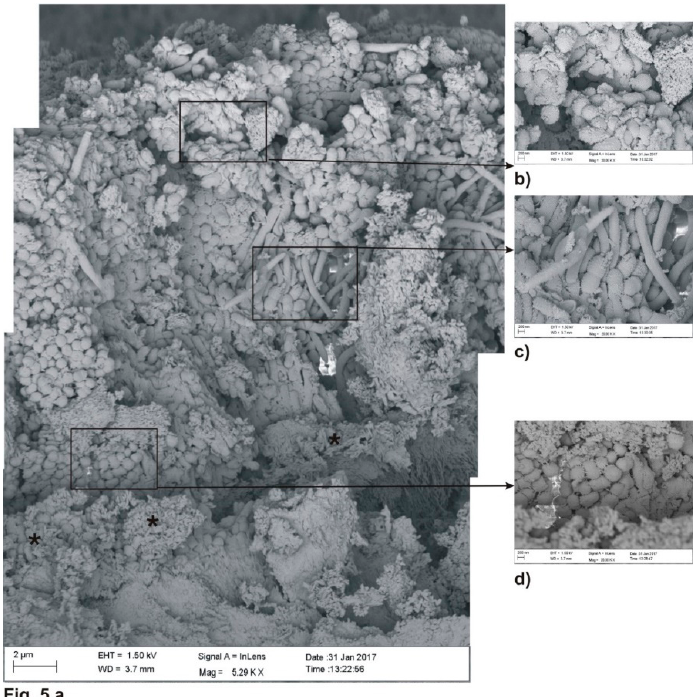
Figure 5. Fractured 5–days-grown biofilm demonstrating stratification. ( a ) Overview, ( b ) basic layer with cocci, ( c ) middle layer showing rods and cocci, and ( d ) surface layer with loose bacteria and some extracellular matrix.